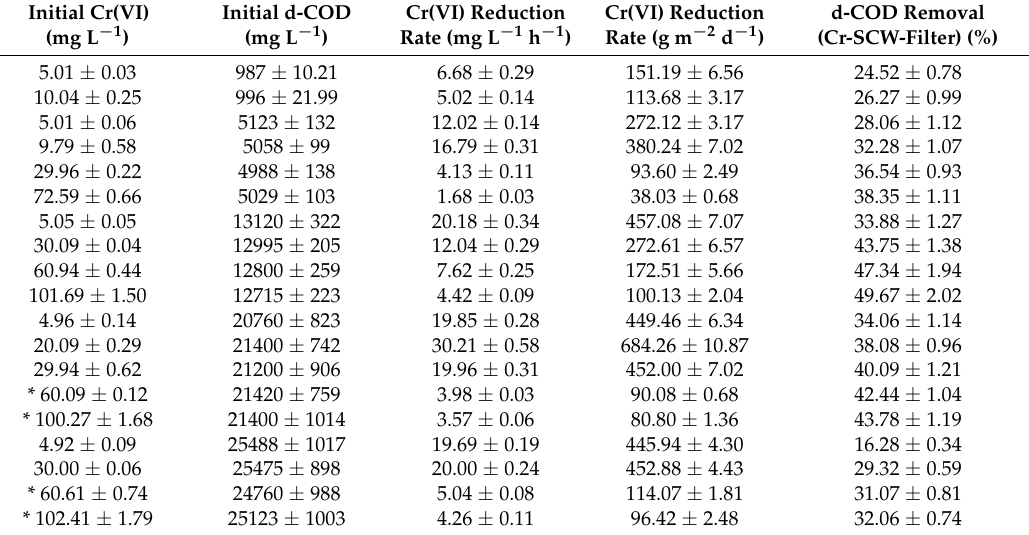
Table 3. Cr(VI) reduction and d-COD removal rates for the different initial Cr(VI) and d-COD concentrations tested in the Cr-SCW-filter operating under SBR with a recirculation rate of 1.0 L min − 1